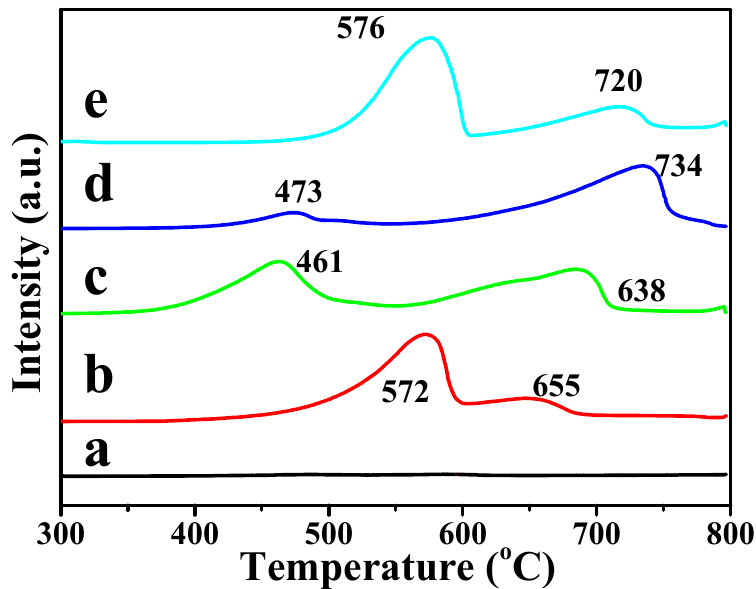
Figure 6. H 2 -TPR profiles of the La 2 O 3 and X-La 2 O 3 catalysts. ( a ) La 2 O 3 ; ( b ) Li-La 2 O 3 ; ( c ) Mg-La 2 O 3 ; ( d ) Zn-La 2 O 3 ; ( e ) Ce-La 2 O 3